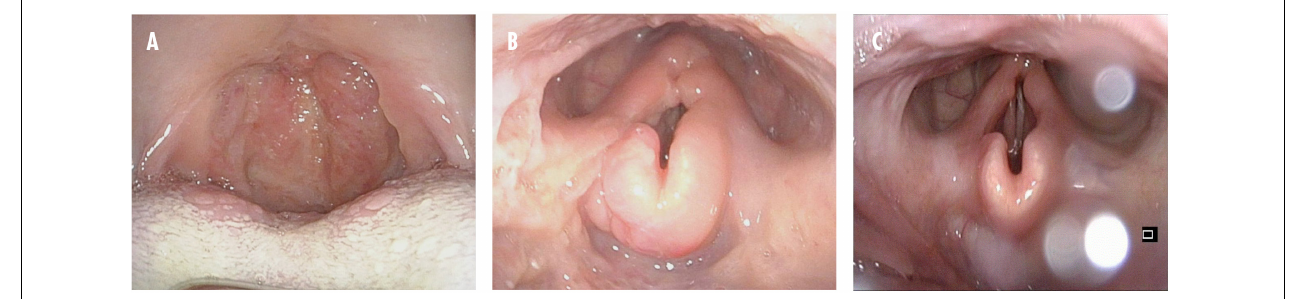
FIGURE 1 | Clinical pictures from oropharyngoscopy and laryngoscopy from the third relapse. (A) Before treatment. The oral cavity and oropharyngeal isthmus show swelling, papilloma-like lesions, and eroded uvula. (B) Before treatment. Swelling of the epiglottis vestibular folds and aryepiglottic folds are seen. (C) One month after treatment. Near-normal